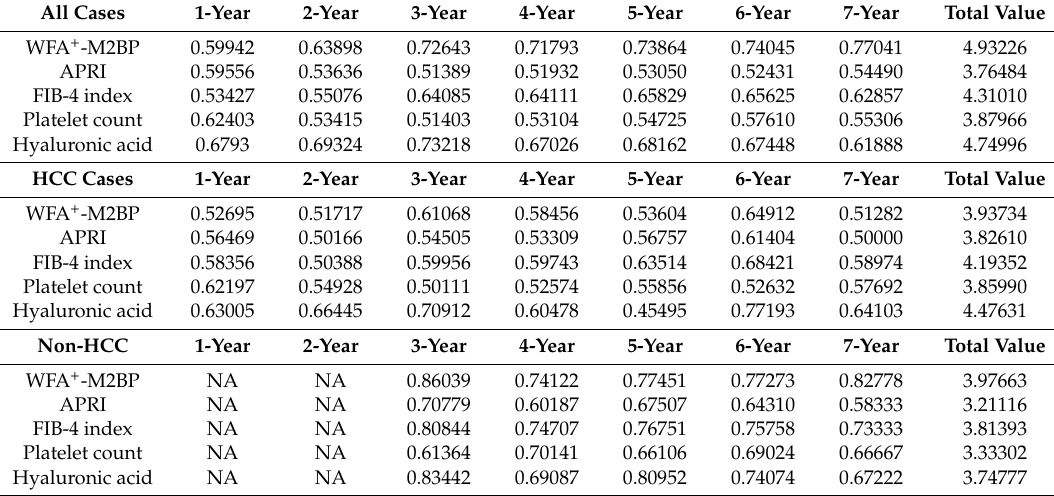
Table 3. Results for time-dependent receiver operating characteristics analysis.